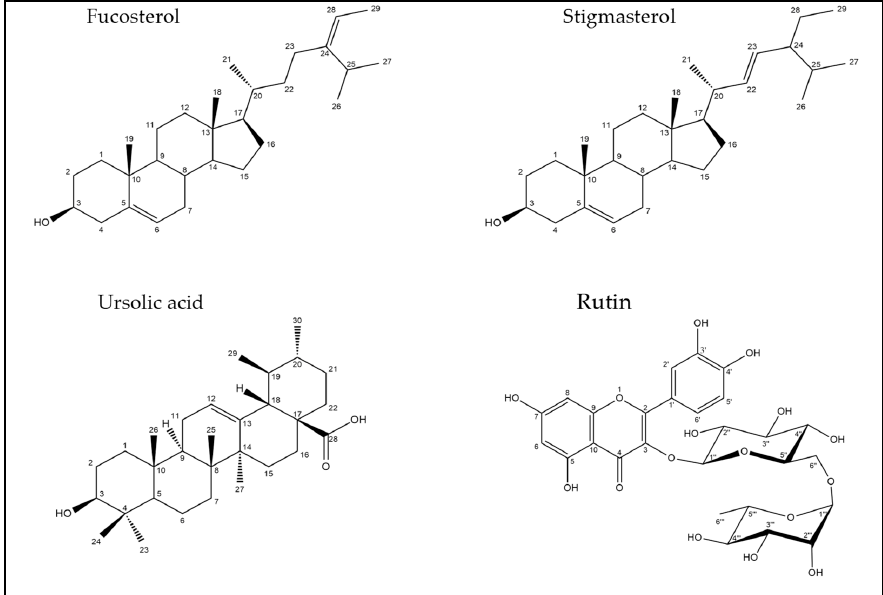
Figure 4. Structures of the isolated compounds from G. thunbergia methanol extract of leaves, (1) Fucosterol, (2) Stigmasterol, (3) Ursolic acid, and (4)